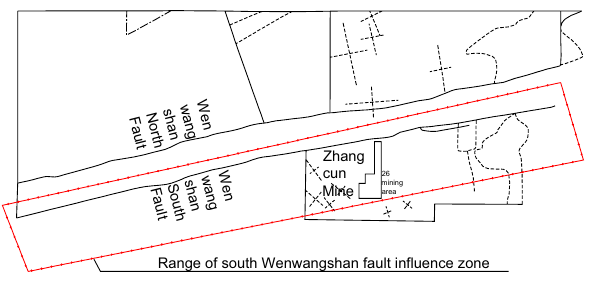
Figure 3. Relative position relationship between the Wenwangshan fault influencing area and the Zhangcun mine.